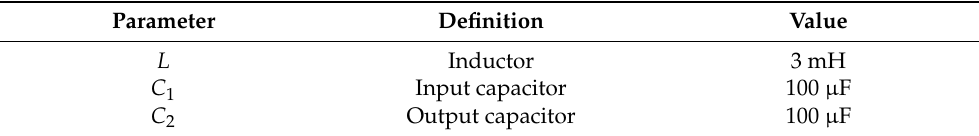
Figure 1. System General Configuration illustrated by Simulink model. Table 1. Boost converter design parameters [36]. Table 1. Boost converter design parameters